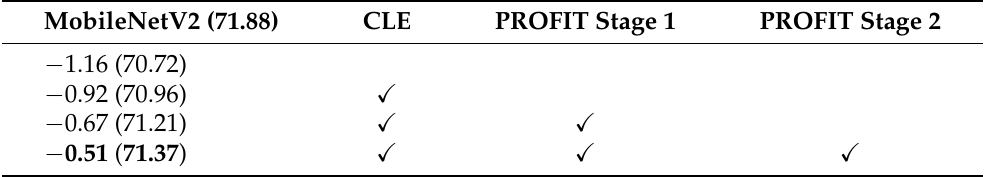
Table 6. Ablation study of the CLE [22] and PROFIT [9] methods on quantized MobileNetV2 with our quantization method. PROFIT Stage 1 is a second round of training where 1/3 of the layers have frozen weights, and PROFIT Stage 2 is a third round of training where 2/3 of the layers have frozen weights.